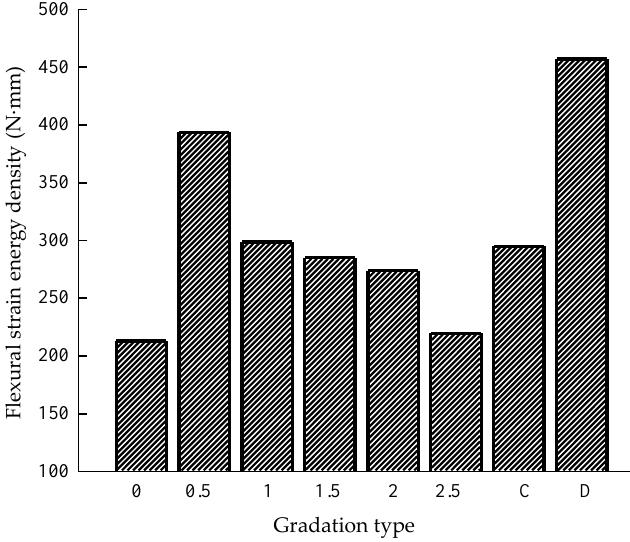
Figure 9. Flexural strain energy density for different mixture types.